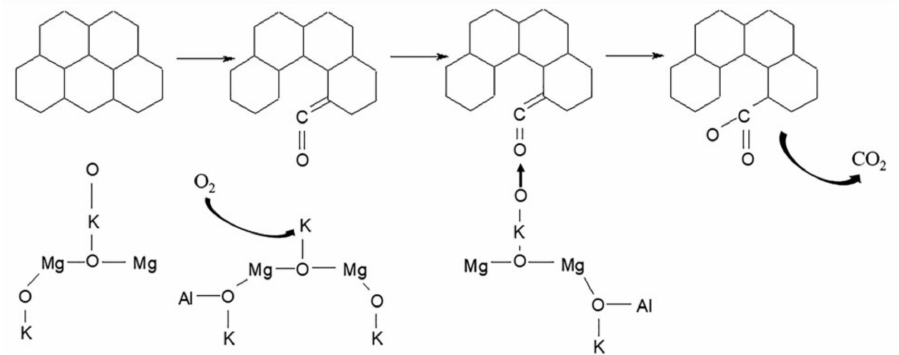
Figure 9. The oxygen overflow mechanism of soot oxidation [120]. Copyright 2019, Elsevier.